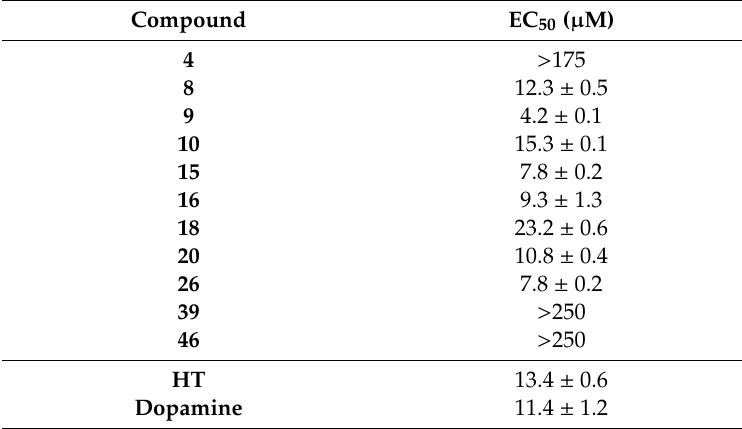
Table 1. Antiradical activity for organochalcogen